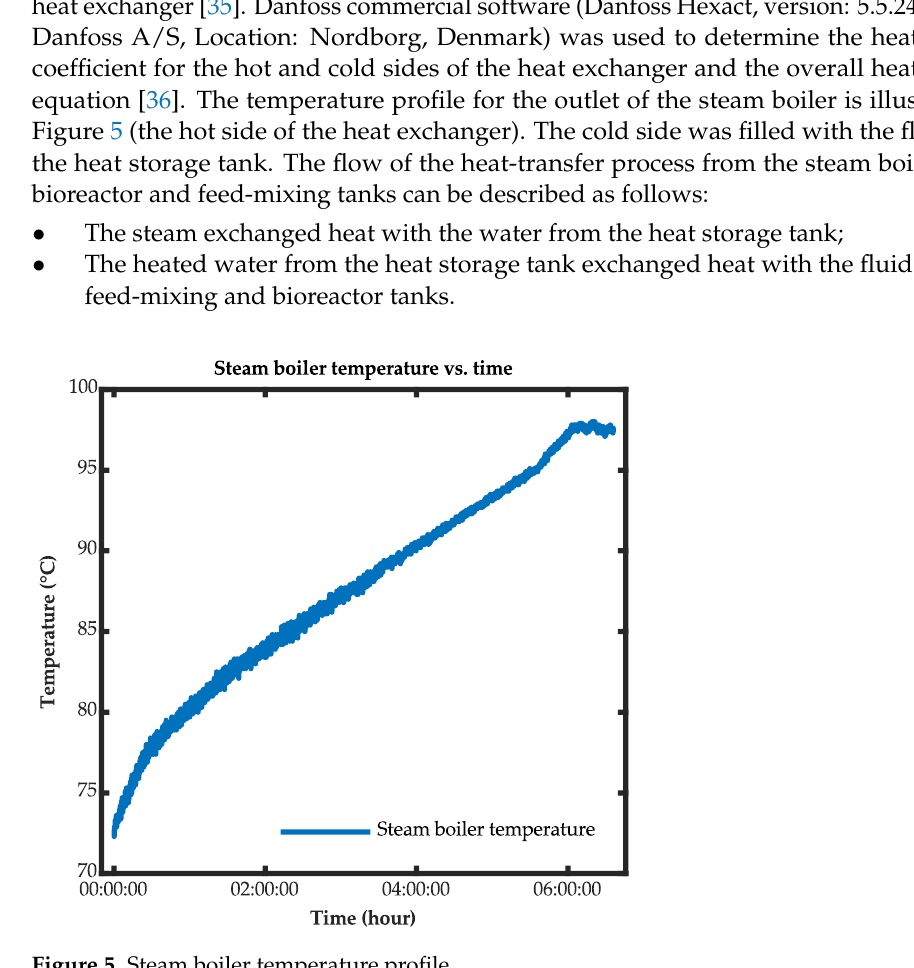
Figure 5. Steam boiler temperature profile.